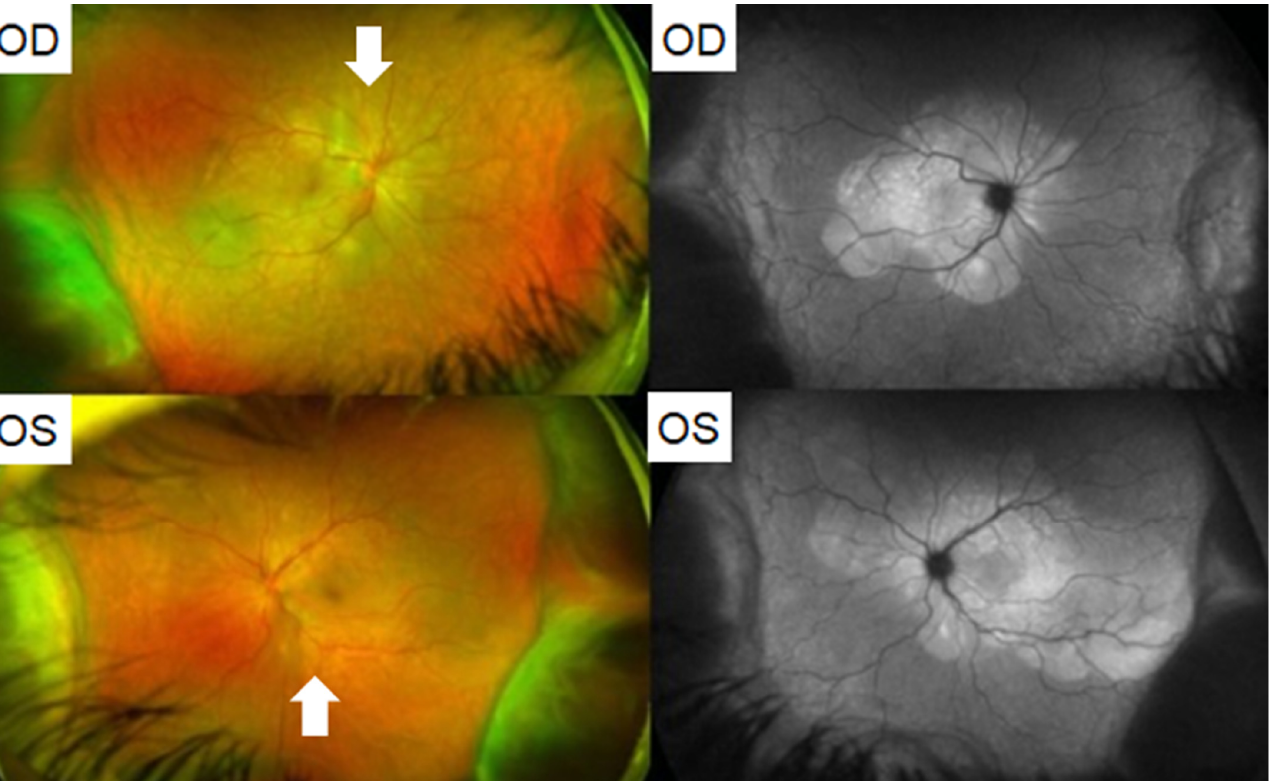
Figure 2. (Patient 1) Fundus photography and autofluorescence of both eyes showing serous retinal detachment (white arrows) and optic disc hyperemia. Adapted from Saraceno, J.J.F.; Souza,